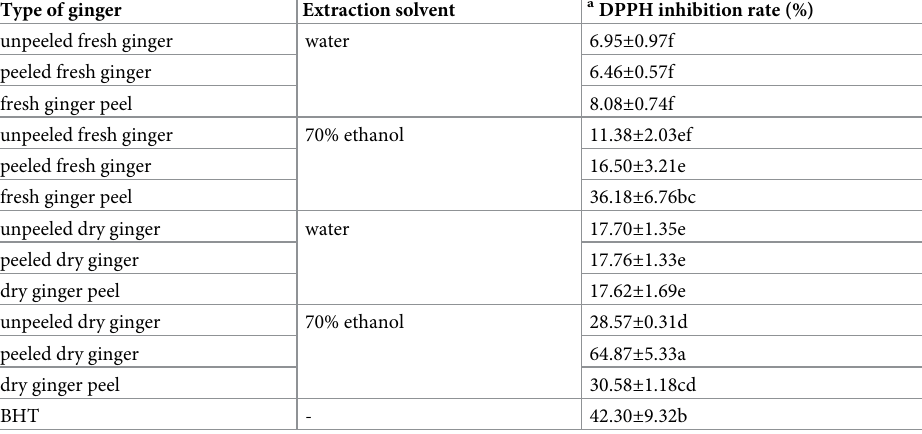
Table 2. Antioxidant activity of Z . officinale AgNPs by DPPH radical scavenging (Mean ± SD, n = 3).